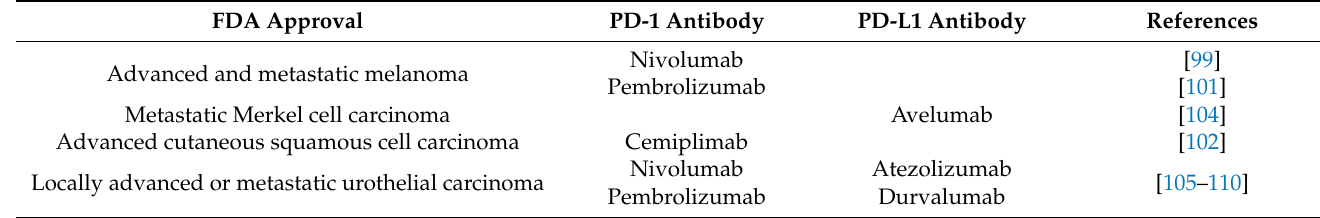
Table 1. FDA-approved treatment regimen for blockade of the PD-1/PD-L1 axis in tumor